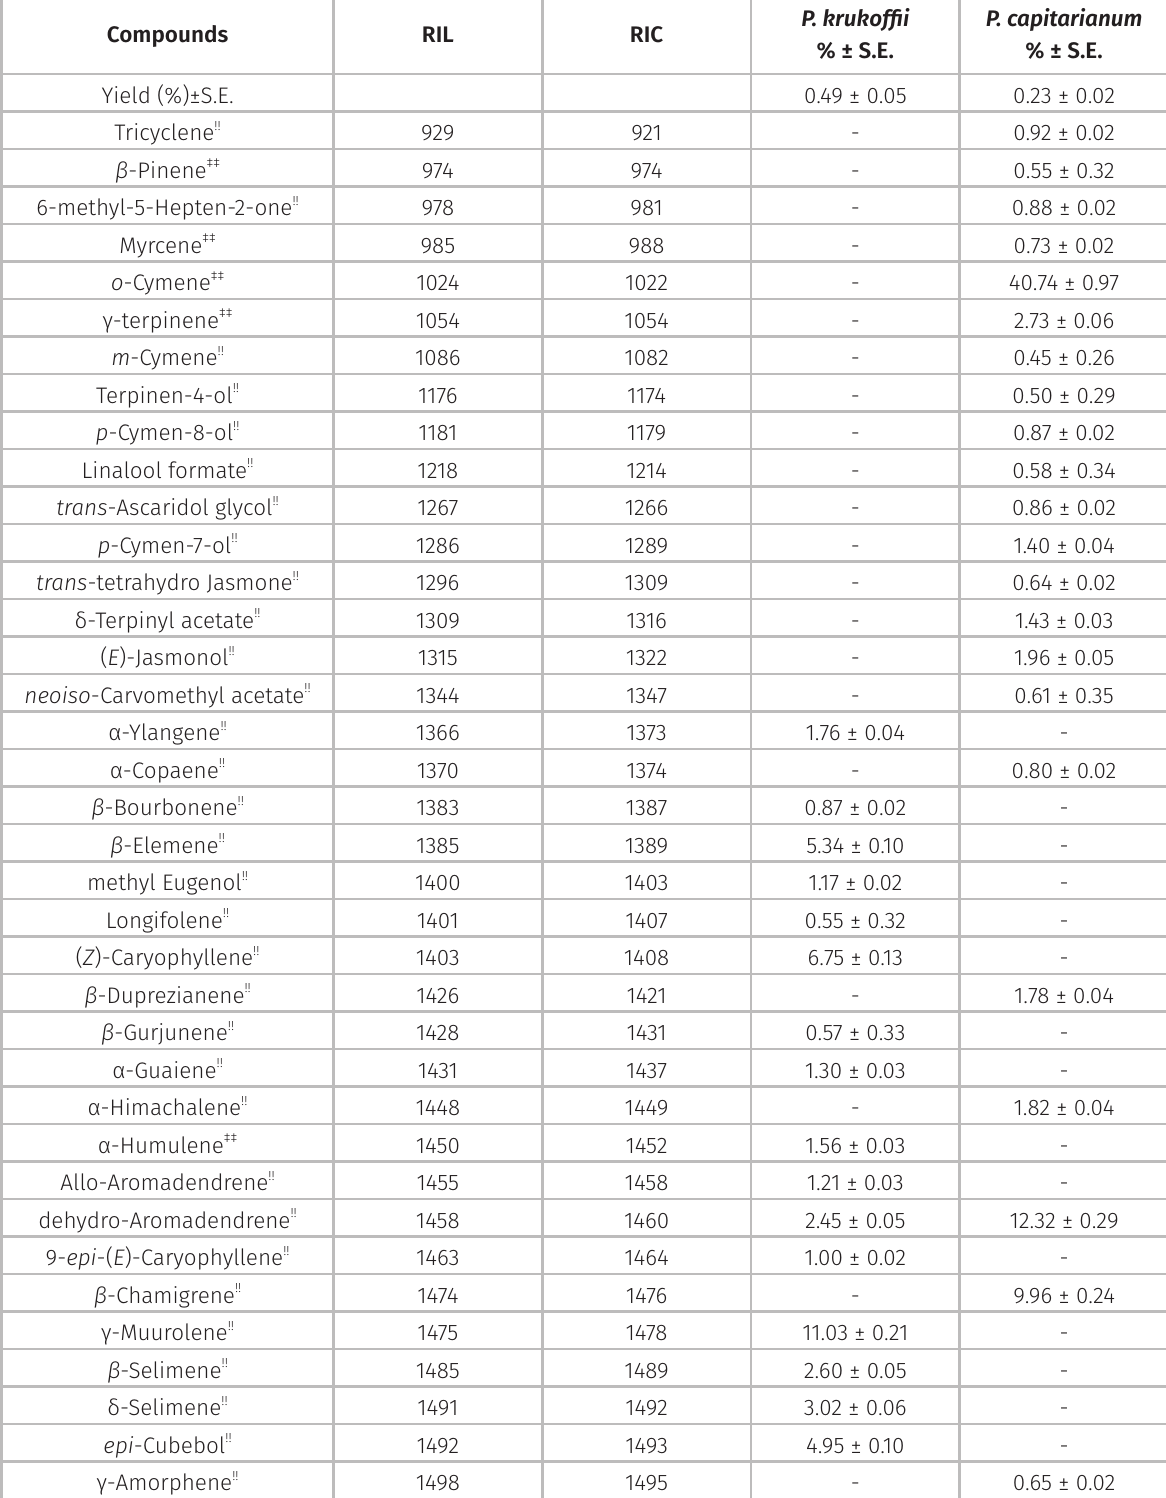
P. krukoffii P. capitarianum % ± S.E. % ± S.E.